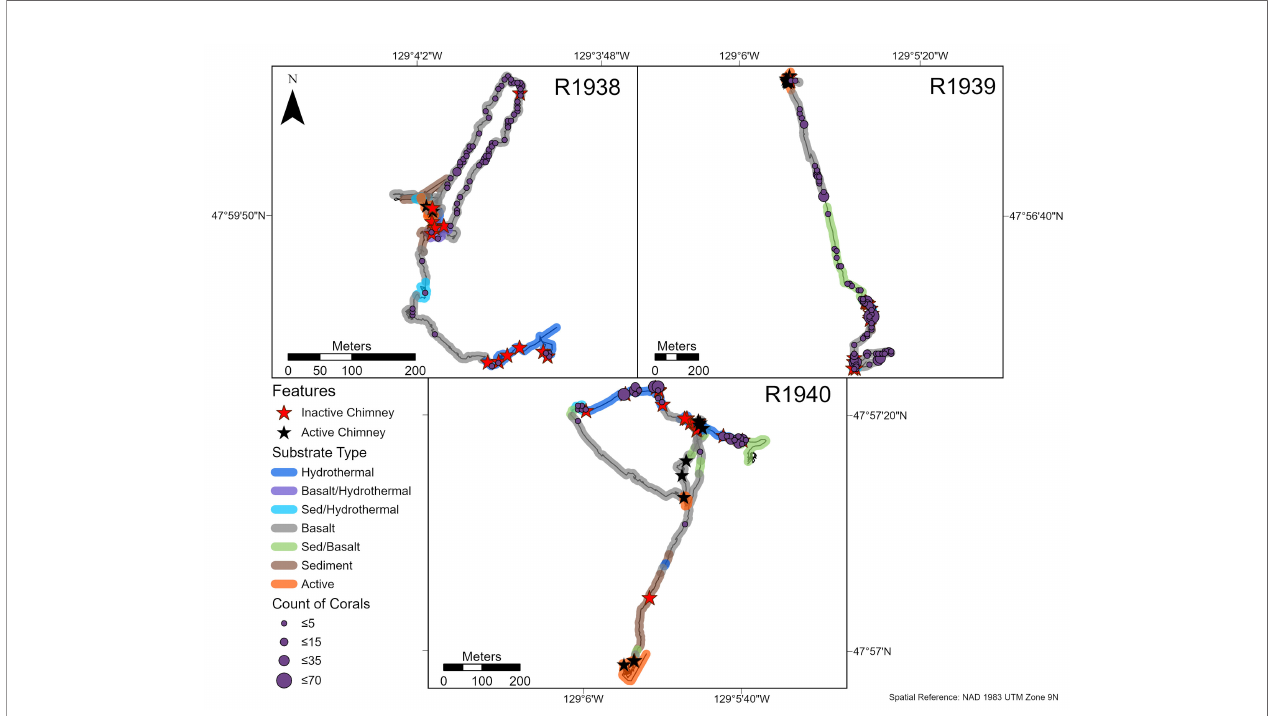
FIGURE 3 | Abundance and distribution of deep-water corals (see Results for dominant morphotaxa) on dives R1938-R1940 at the Endeavour segment, Juan de Fuca Ridge in August 2016. Inactive and active chimney locations and broad scale substrate classi fi cations are also plotted onto the track. “ Hydrothermal ” substrate refers to inactive substrate that is hydrothermally derived. Counts were summed over a 10 x 10 m tessellation in ArcGIS